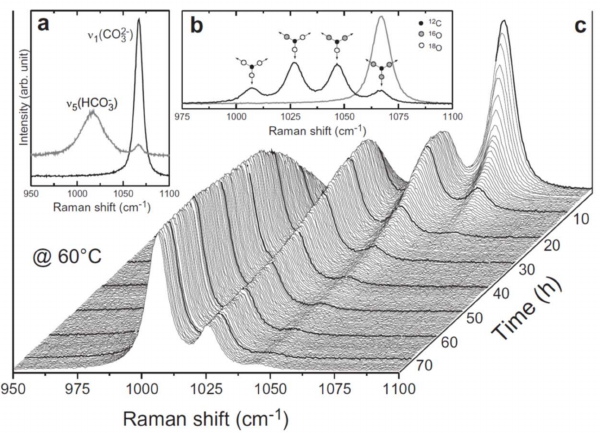
Figure 2. Isotopic exchange of aqueous carbonate ion with 18 O-enriched water. ( a ) Raman spectra from a 1 M sodium carbonate (lower spectrum) and bicarbonate (upper spectrum) solution, showing the − ) band near 1065 and 1016 cm − 1 , respectively. ( b ) Isotopologue bands of 32 − ) and the ν ν 1 (CO 5 (HCO 3 CO 32 − ion in solution. The dark line shows the enriched carbonate population present in a 1 M NaCO 3 solution after 10 h at 60 ◦ C and the grey spectrum represents the initial spectrum of the solution shortly after being heated to 60 ◦ C, showing only the ν 1 (C 16 O 32 − ) band. ( c ) Time-resolved Raman spectra of the ν 1 (CO 32 − ) band, illustrating the O isotope exchange between aqueous CO 32 − and water at 60 ◦ C. Reprinted from Geochimica et Cosmochimica Acta, vol. 90, Geisler et al., “Real-time monitoring of the overall exchange of oxygen isotopes between aqueous CO 3 2 − and H 2 O by Raman spectroscopy”, pages 1–11, (2012), with permission from Elsevier